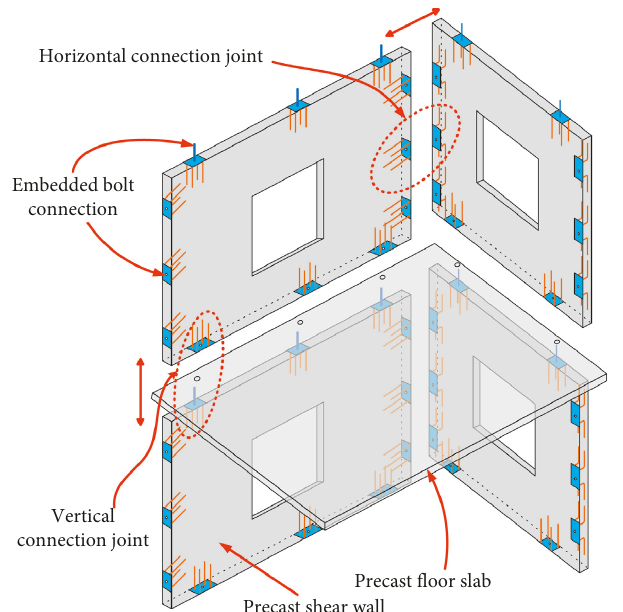
Figure 3: Low-rise precast structure system with full bolt connections.